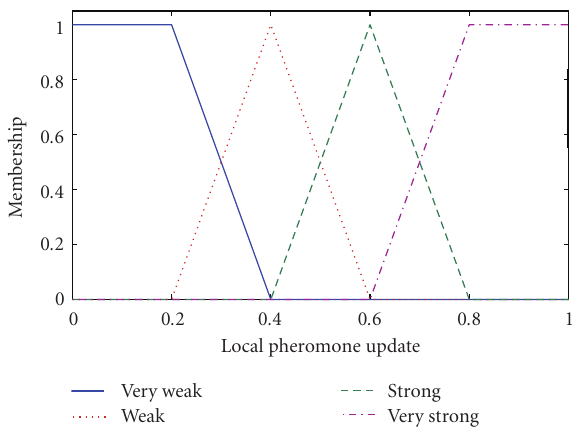
Figure 10: Membership function of local pheromone updating.